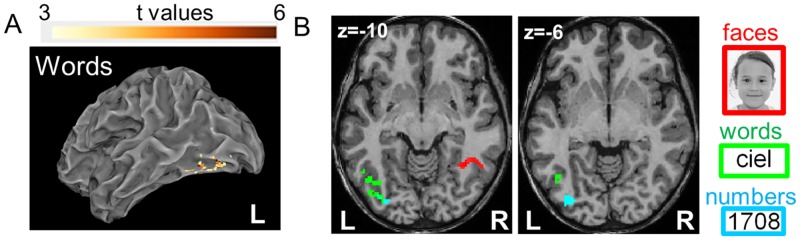
Brain activations correlating with reading speed as it evolves across scanning sessions, independently of age.(A) Effect of reading speed (LUM) on word-evoked activations relative to rest, in a model in which age was also entered as a covariable. (B) Reading speed effect on the activation evoked by faces, words, and numbers. Activation to words (green) and numbers (blue) increased with reading speed in the left occipitotemporal pathway. Reading expertise was also associated with increased responses to faces in the right fusiform gyrus (red). No significant effect was seen for the other categories. All contrasts at voxelwise p < 0.001 and clusterwise p < 0.05 FWE corrected. FWE, family-wise error; LUM, “Lecture en une minute.”